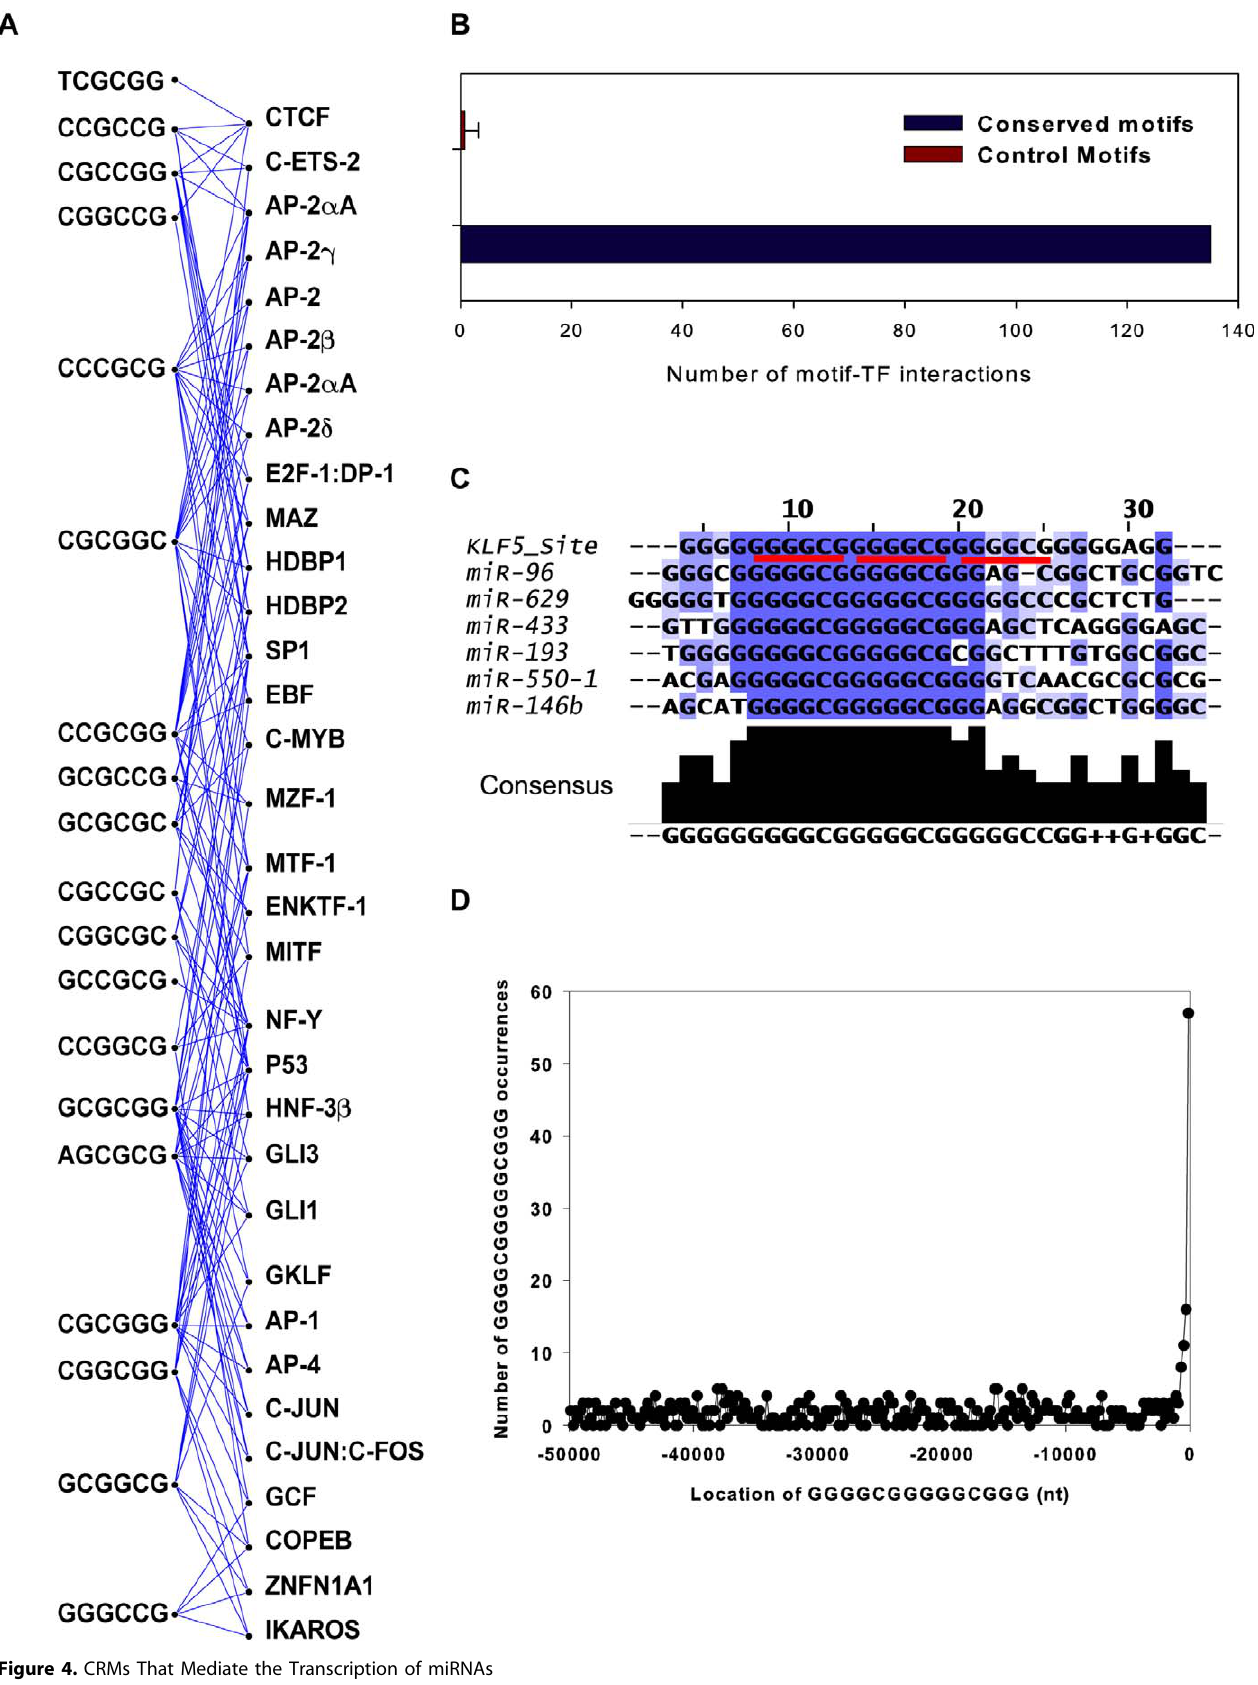
Figure 4. CRMs That Mediate the Transcription of miRNAs (A) Network of CRMs that are overrepresented in the upstream regions of human, mouse, and opossum miRNAs and their predicted TF interactors. (B) Numbers of predicted CRM–TF interactions for 22 evolutionarily conserved mammalian CRMs and 22 control motifs (Methods) in 100 control datasets. The error bar corresponds to the standard deviation of the number of predictions for the 100 control datasets. PLoS Computational Biology |